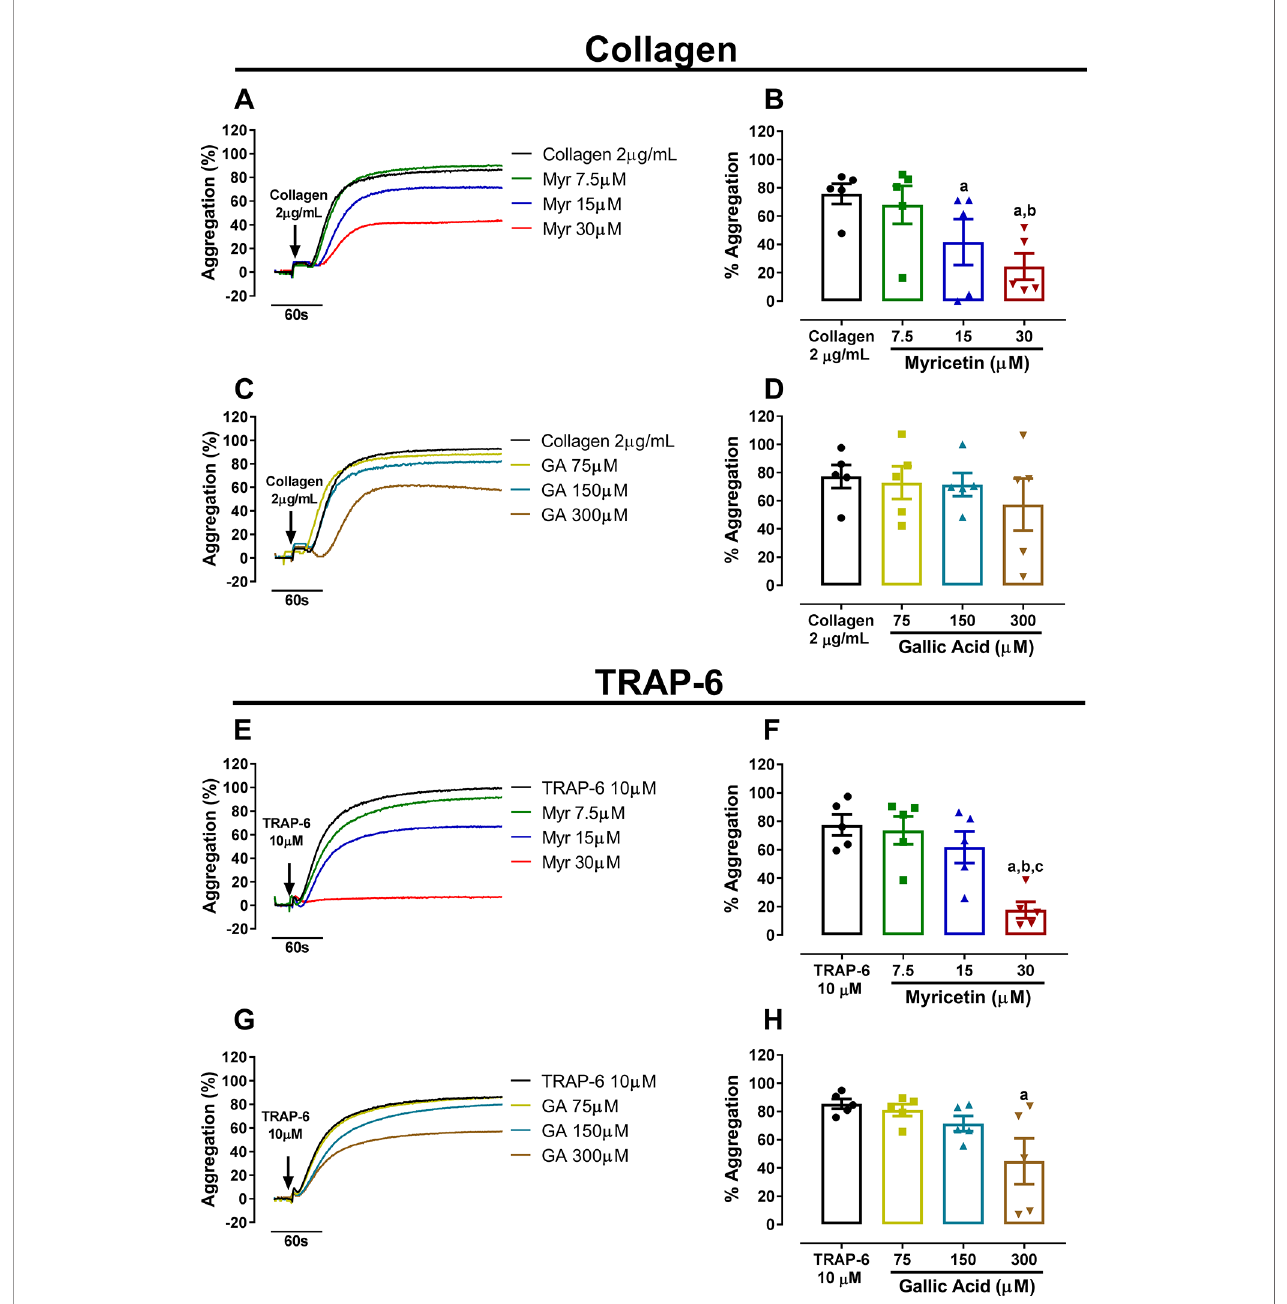
FIGURE 2 | Myricetin inhibits platelet aggregation more potently than gallic acid. Washed platelets (WP) were pre-treated with myricetin (Myr) or gallic acid (GA) for 10 min and stimulated with collagen or TRAP-6. (A, B) WP treated with Myr and stimulated with collagen. (C, D) WP treated with GA and stimulated with collagen. (E, F) WP treated with Myr and stimulated with TRAP-6. (G, H) WP treated with GA and stimulated with TRAP-6. Quanti fi ed data is shown right next to representative curves. a p < 0.05 vs fi rst column of graph. b p < 0.05 vs second column of graph. c p < 0.05 vs third column of graph. Data analyzed by paired one-way ANOVA and Tukey as post-test. All bar graphs represent mean ± SEM and individual data points of at least three independent experiments. Arrows indicate when agonists were